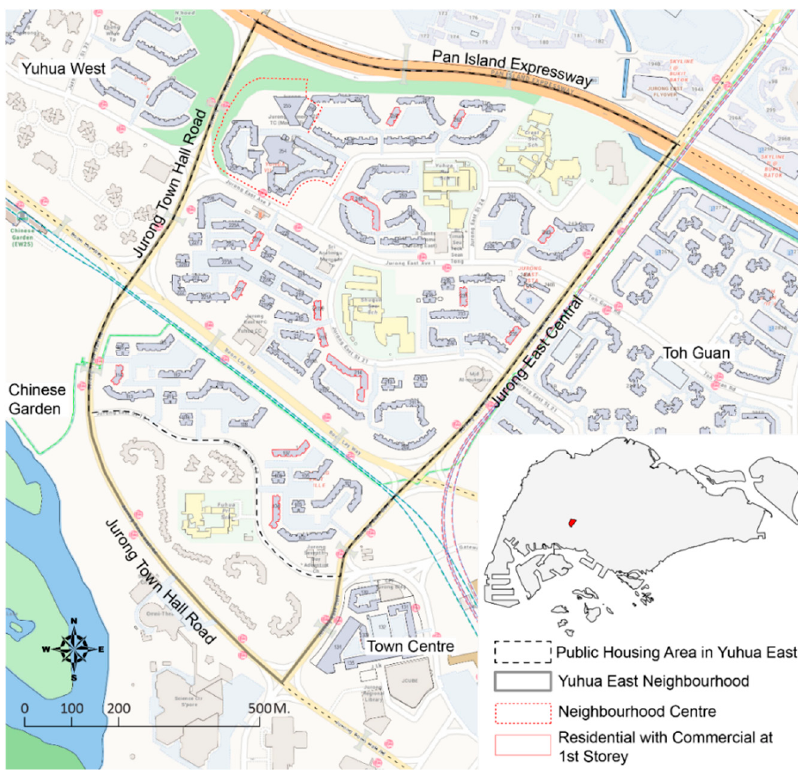
Figure 1. Location and site plan of the Yuhua East neighborhood.